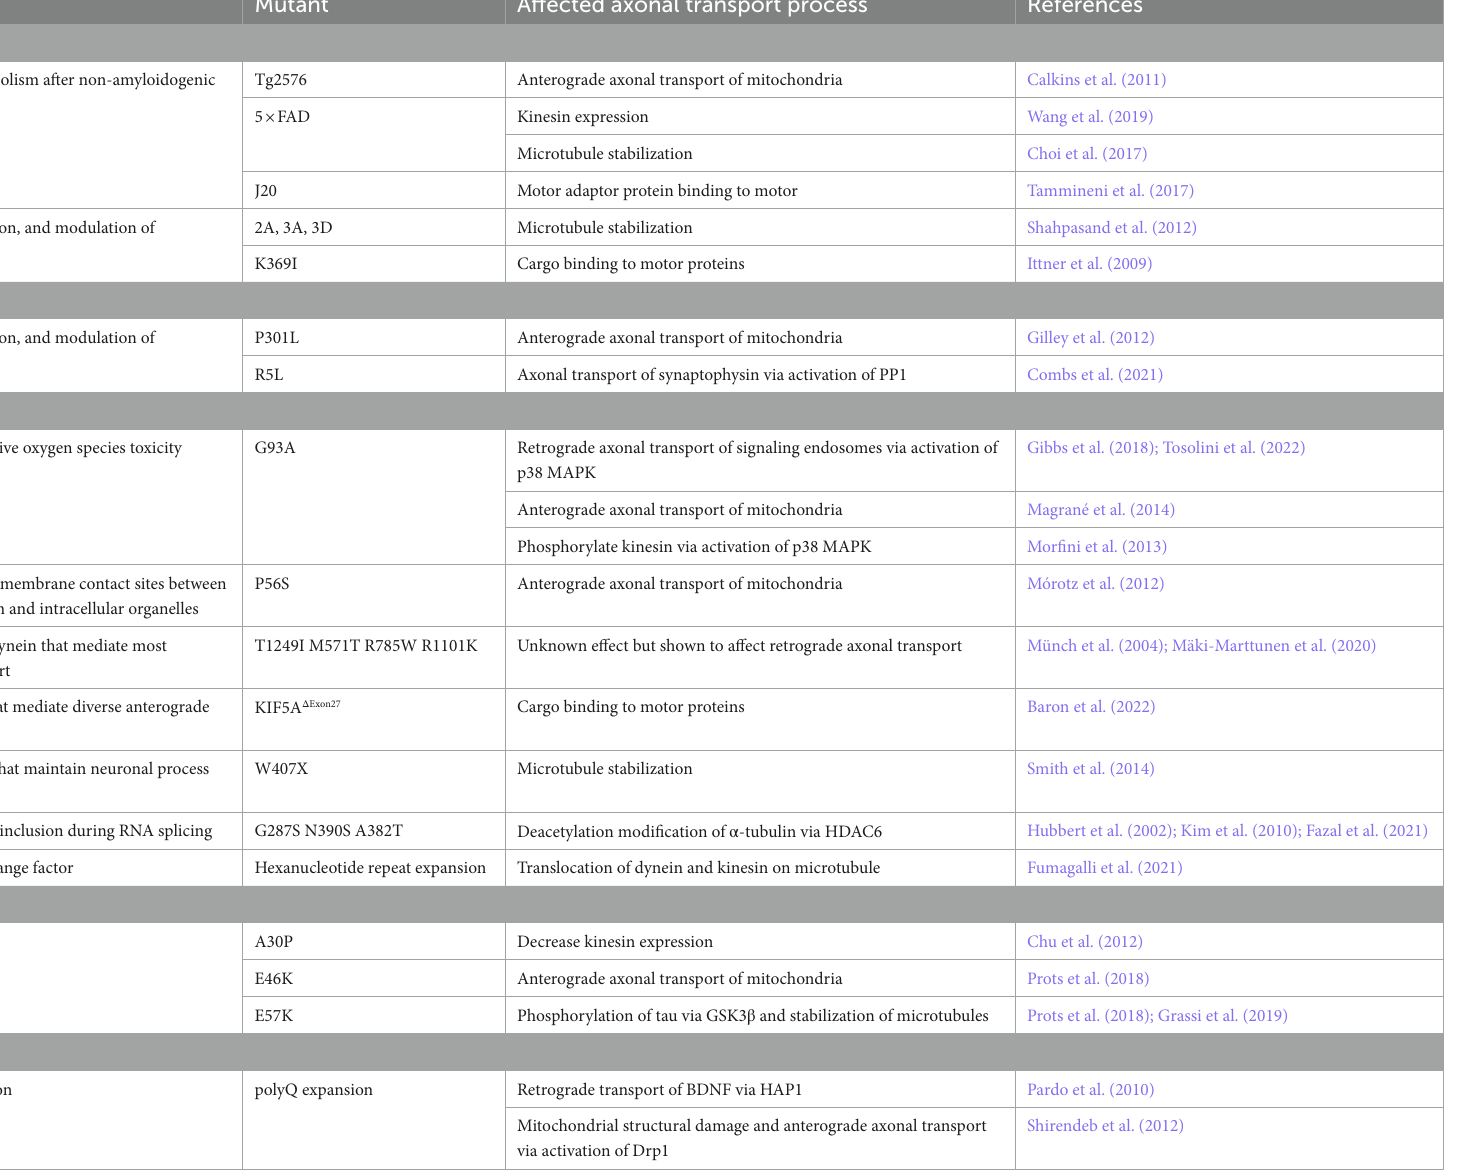
TABLE 1 Mutations in axonal transport deficits of neurodegenerative diseases. Gene